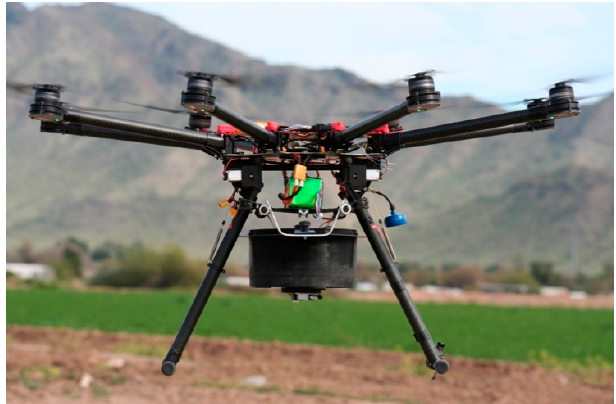
Figure 1. Photograph of the Hermes uncrewed aircraft system (UAS) used to release sterile codling moths in the Okanagan in 2016 and 2017. The UAS is shown in flight. The moth storage and release device is mounted under the airframe, between the landing gear.